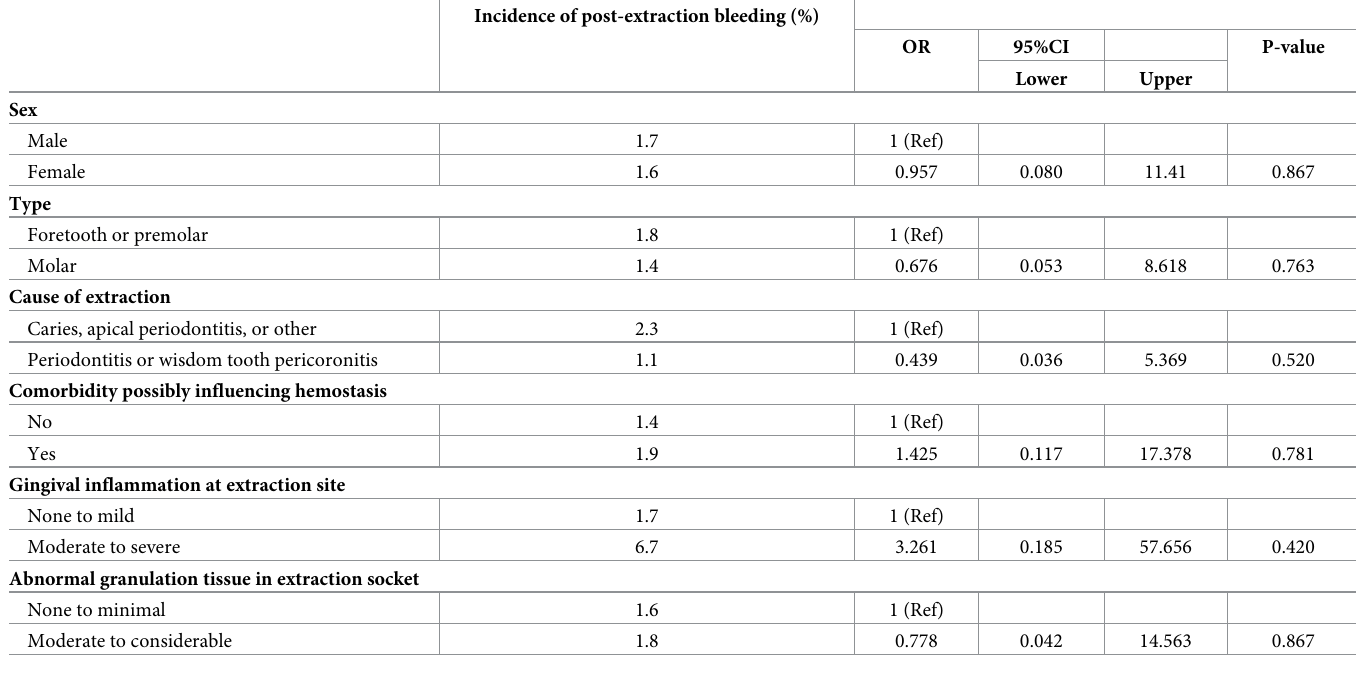
Table 4. Multivariate analysis of risk factors for post-extraction bleeding